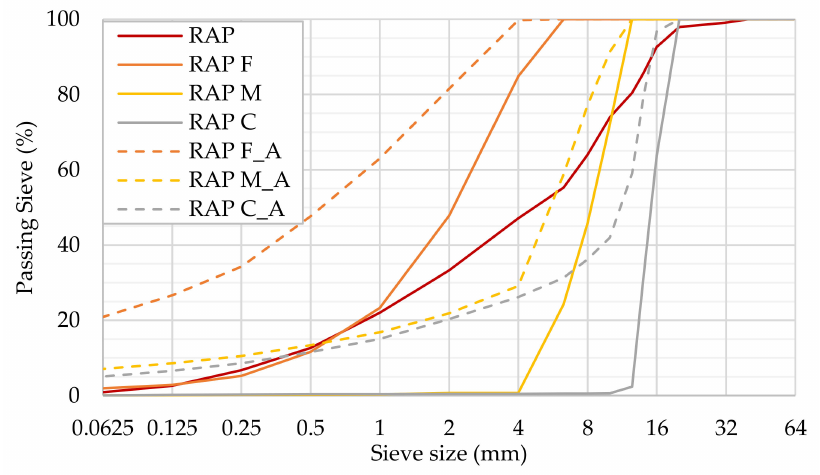
Figure 2. Grading curves of